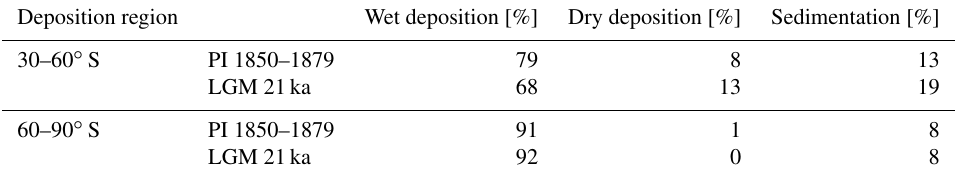
Table 6. Contribution of dust deposition mechanisms to the total dust deposition between 30 and 90 ◦ S during the PI and LGM in percent. Deposition region Wet deposition [%] Dry deposition